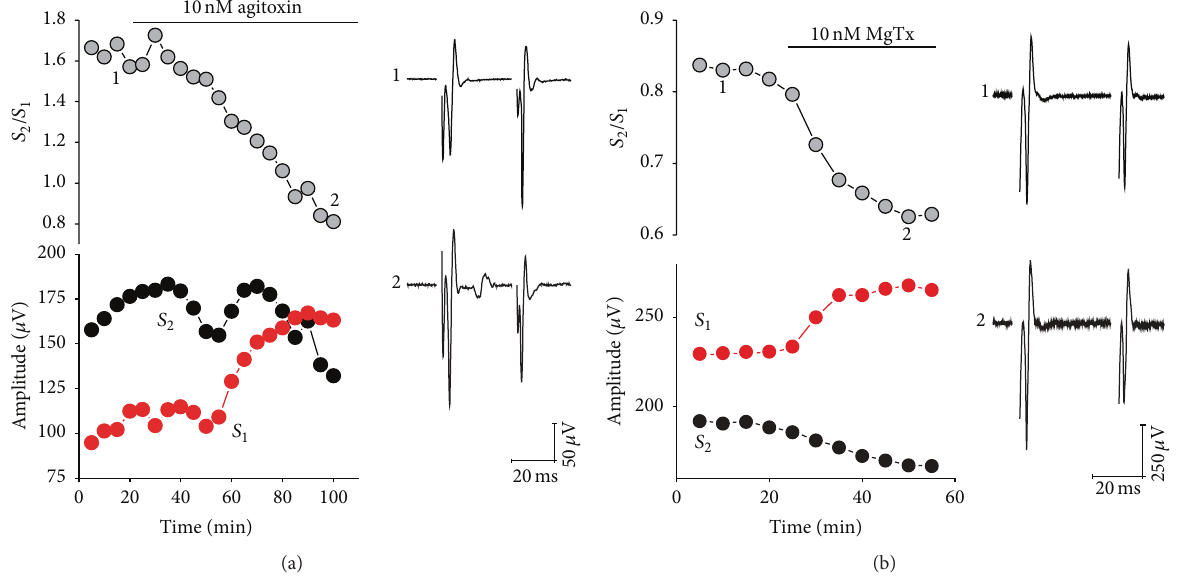
Figure 4: Specific blockers reveal the presence of presynaptic K V 1 family potassium channels at corticostriatal synapses. Representative experiments showing the reduction of PPR after exposure to (a) agitoxin-1 and (b) margatoxin. In both cases, the upper left panels show the time course of PPR as it changes due to drug administration. Horizontal bars indicate time of drug perfusion. Representative traces showing population spikes before (1) and after (2) exposure to drugs are shown in the right panel. The changes in 𝑆 1 (red) or 𝑆 2 (black) amplitude are shown on the left lower panels. Initially PPR was adjusted to obtain PPR ≥ 1. Addition of K V 1 specific blockers results in reduction of PPR that was associated with differential effects on 𝑆 1 or 𝑆 2